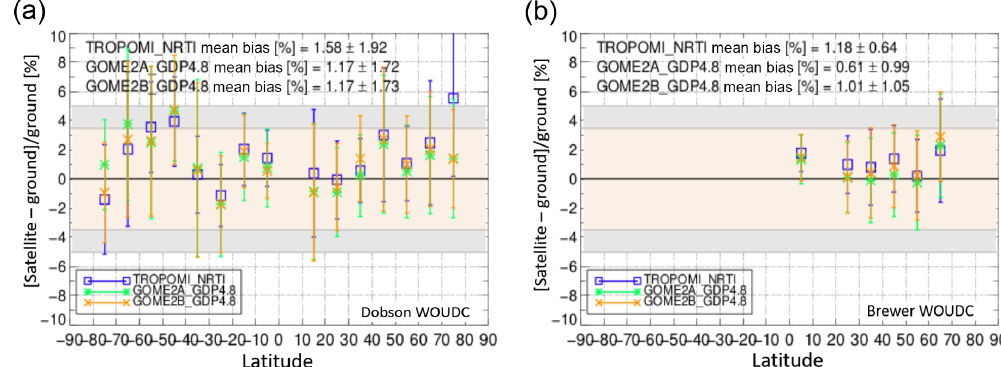
Figure 15. As in Fig. 13 but for the TROPOMI NRTI (blue line), GOME2a (green line) and GOME 2b (orange line)